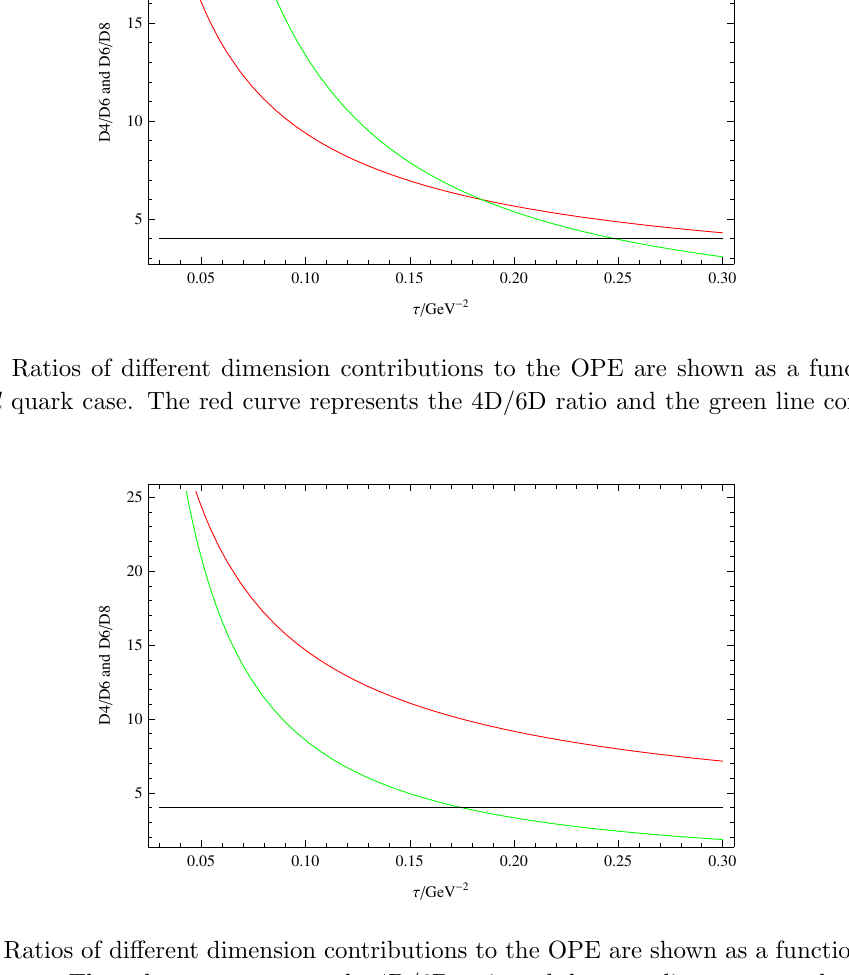
Figure 4 . Ratios of di(cid:11)erent dimension contributions to the OPE are shown as a function of (cid:28) for the s quark case. The red curve represents the 4D/6D ratio and the green line corresponds to